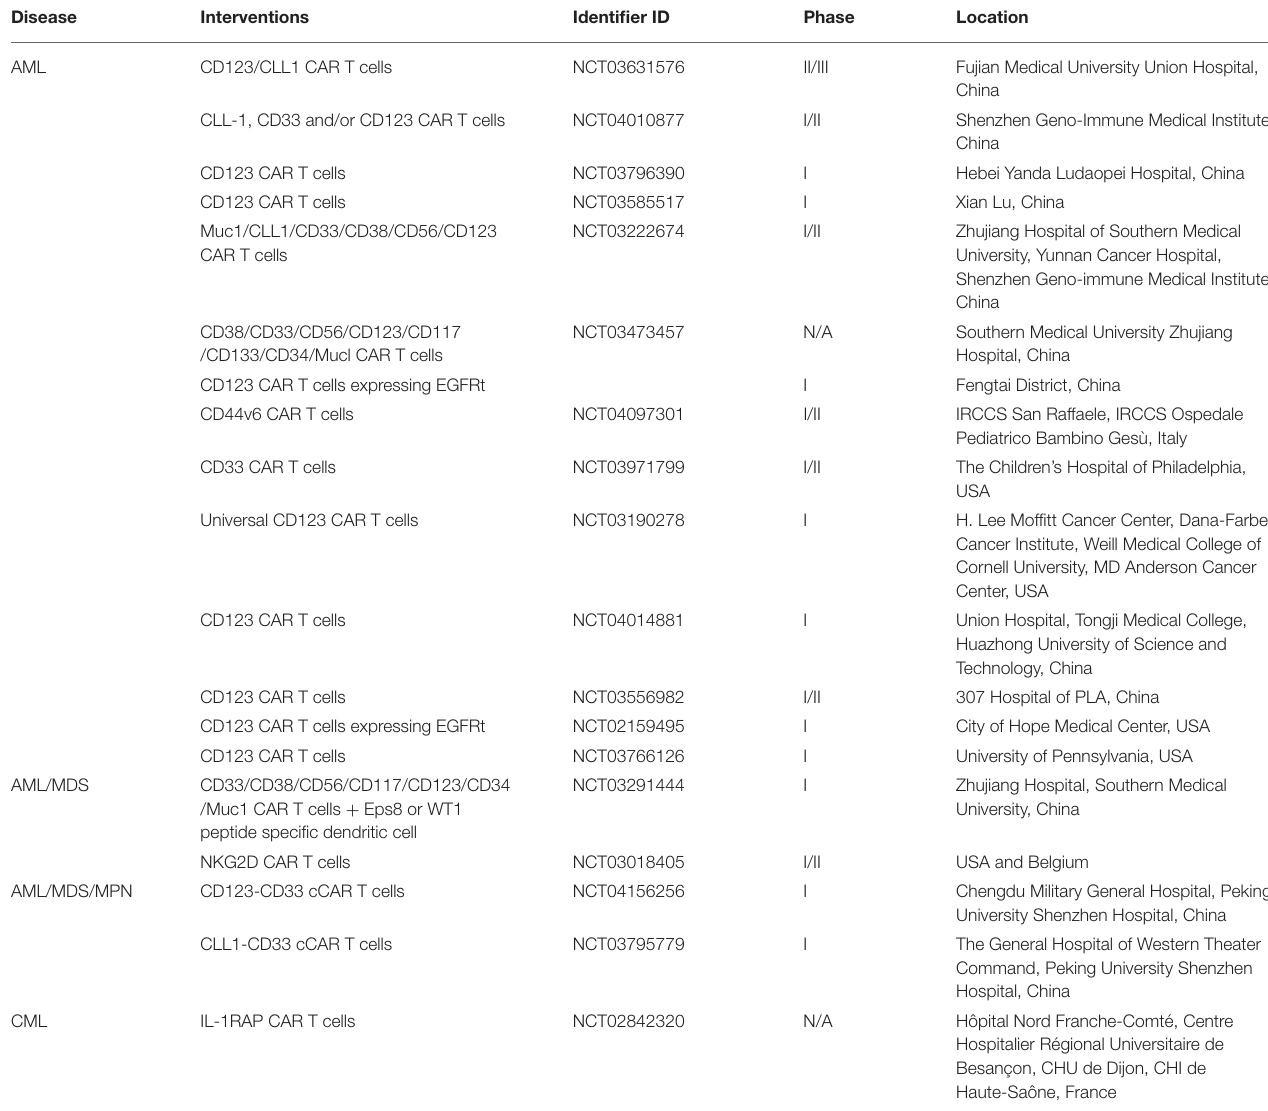
TABLE 1 | CAR T cell trials in myeloid malignancies currently recruiting.